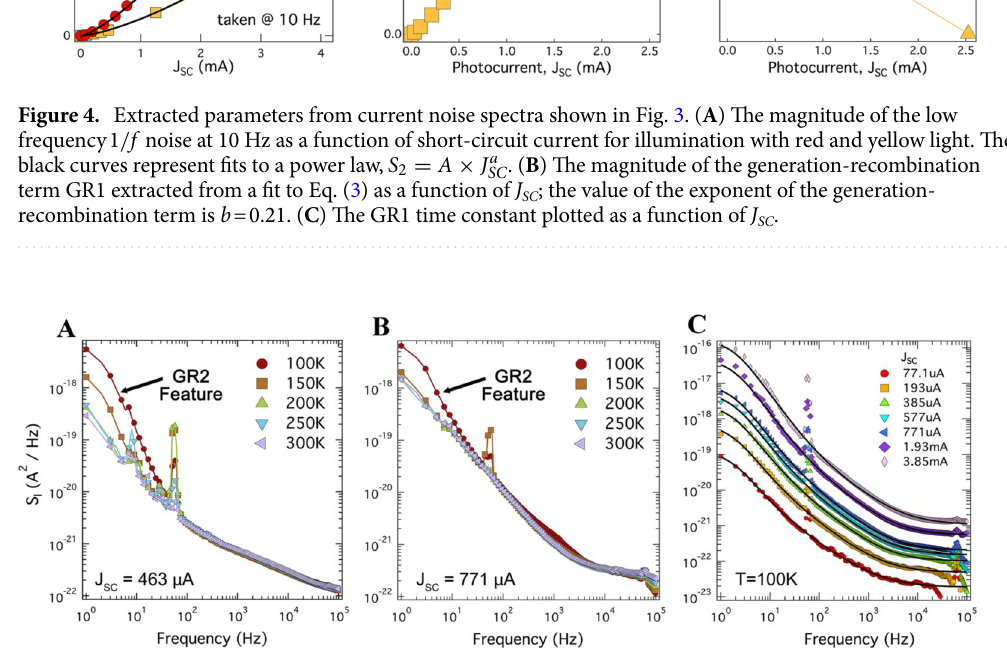
Figure 5. Current spectral density as a function of temperature of the SHJ solar cell SC1 at short-circuit condition. ( A ) The frequency and temperature dependence of the current noise spectra under yellow light illumination, illustrating the near temperature-independence of the GR1 noise term (frequency range 100 Hz–10 kHz). This figure also illustrates an emerging low-temperature Lorentzian feature (GR2 term, τ ≈ 0.1 s ) with decreasing temperature. The noise peak occurring at ~ 60 Hz is caused by mechanical noise introduced by the flow of liquid nitrogen. ( B ) The frequency and temperature dependence of the current noise spectra under red light. Again, the GR2 spectrum with τ ≈ 0.1 s is detected below 100 K. ( C ) The full set of spectra under red light at 100 K. The black curves represent a fit to the sum of Eq.